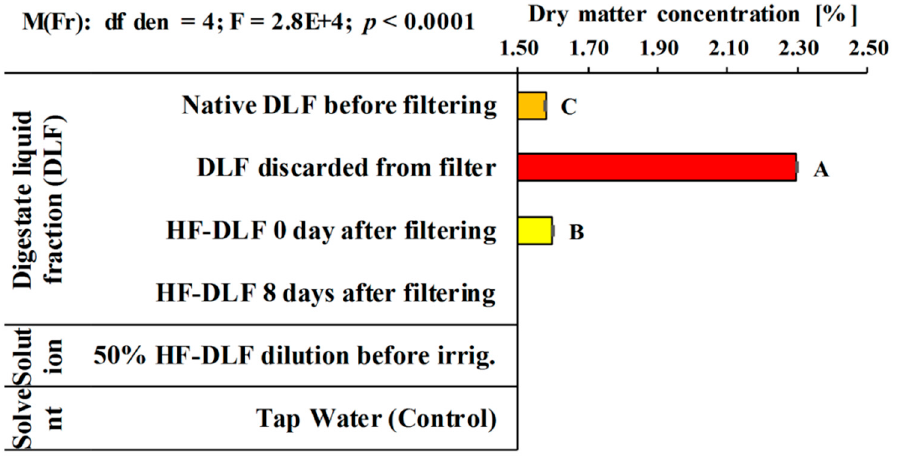
Figure 4. Dry matter concentration of the digestate liquid fraction (DLF), before and after hydrocyclone filtering (HF), the 50% dilution of the HF-DLF, and the tap water used for the experiment. Bars are LSmeans ± Lsmeans standard error estimates. Bars with a letter in common cannot be considered different according to a conservative Tukey-grouping applied to the p -differences of the LSmeans. Results of the statistical analysis are embedded.